Question: According to the figure, is the described quantity increasing or decreasing?
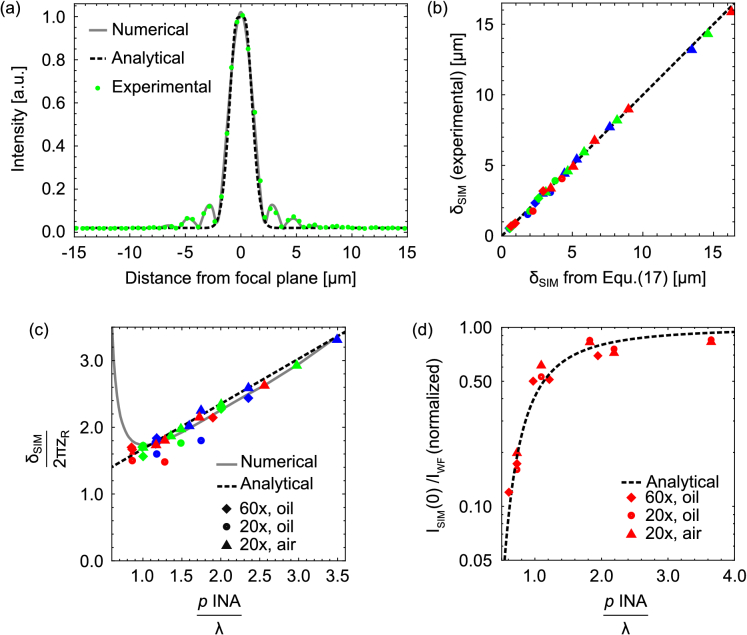
Answer: increasing